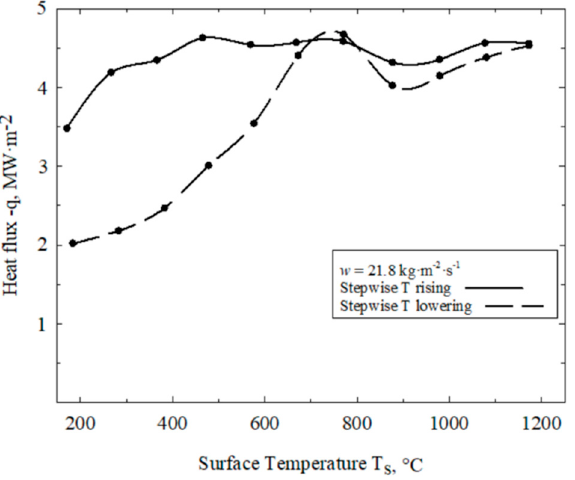
Figure 7. Experimentally determined steady-state boiling curve using hard water-air mist from a Delavan nozzle. Impingement water density, 21.8 kg·m 2 s − 1 .